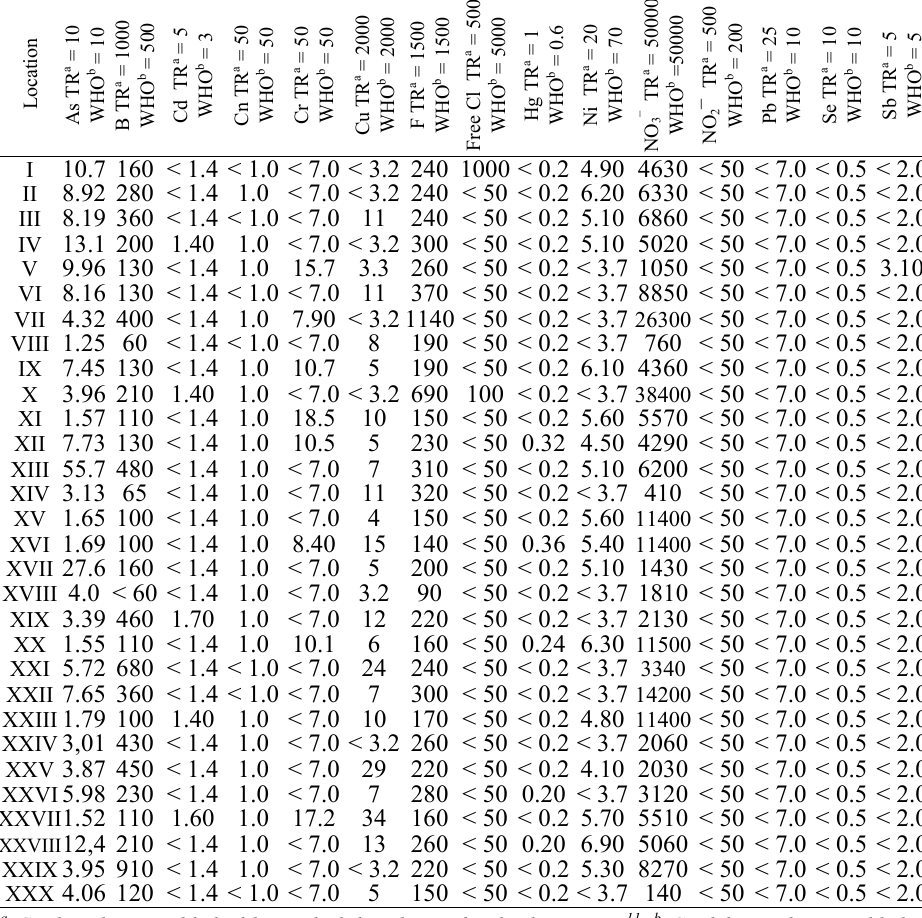
Table 2. Chemical values of the drinking water samples from Cankiri, Turkey (μg/L).